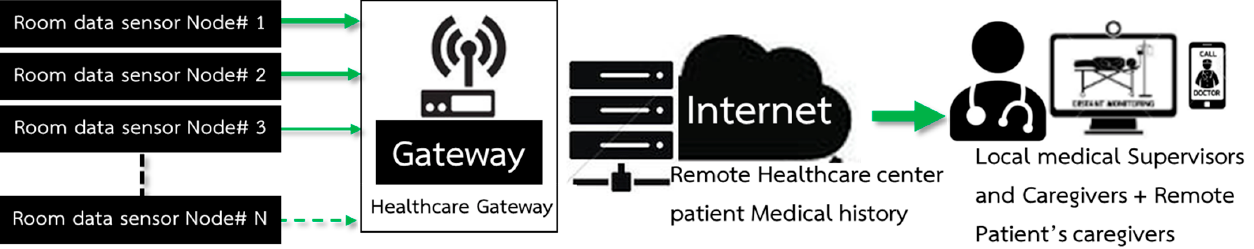
Figure 5. A structure of the communication between sensor node and room data sensor node (#I.D.) to the healthcare database center.